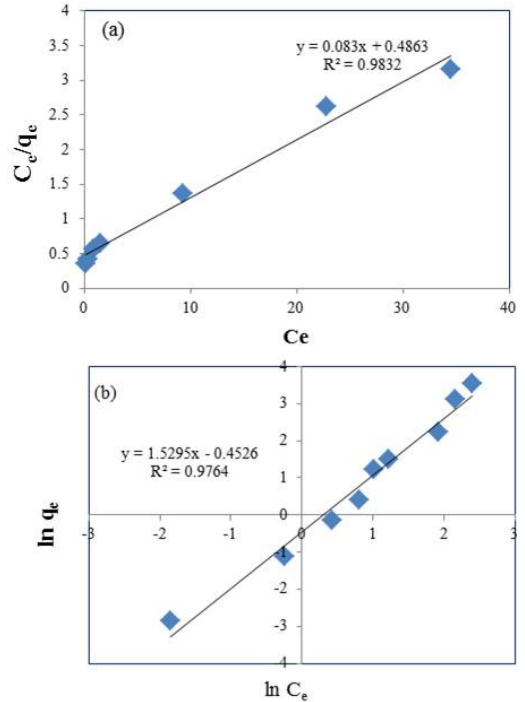
Fig. 12 The (a) Langmuir and (b) Freundlich isotherm plots for As(III) adsorption by CM-βCD-MNPs at pH 9.